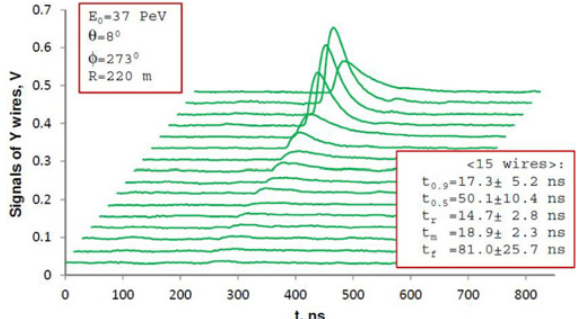
Figure 10. The Cherenkov pulse shape detected using 32 channels of the telescope DAS: 16 Y wires.